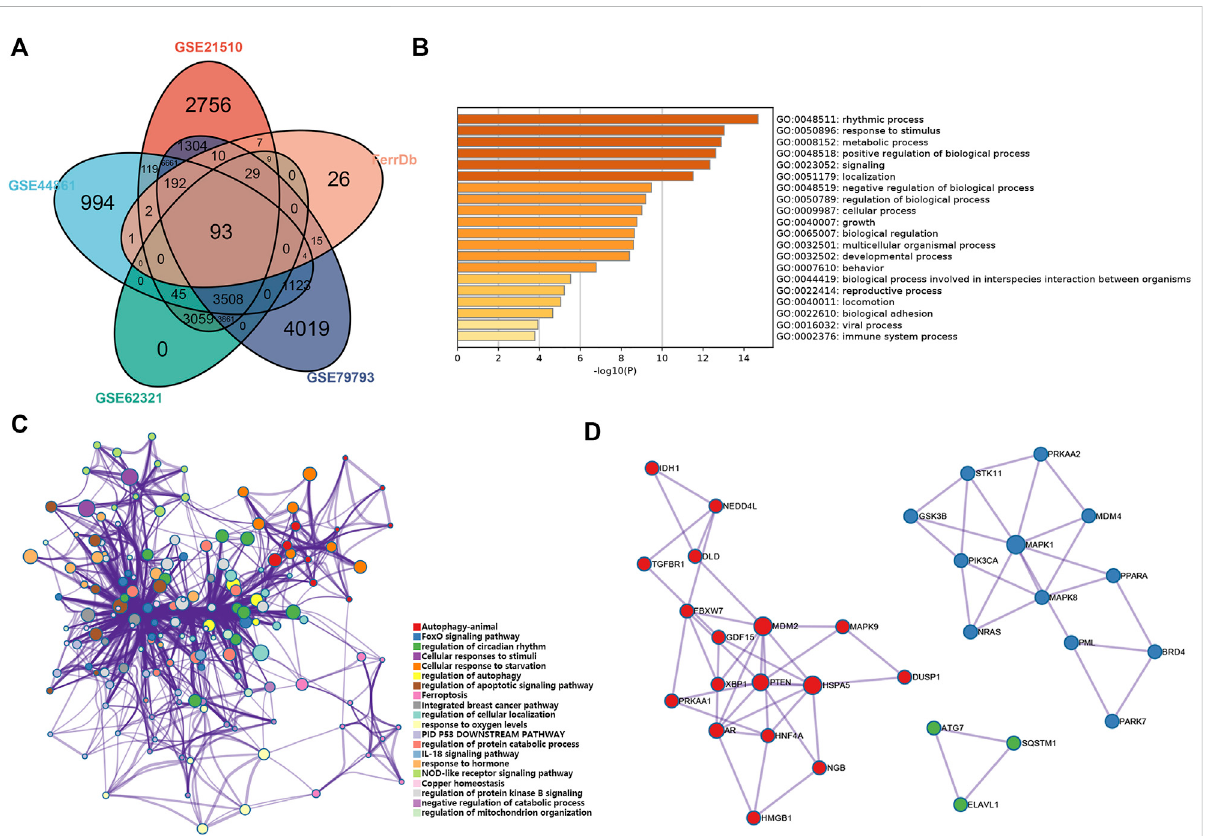
FIGURE 2 Analysis of the ferroptosis-related DEGs in CRC. (A) Venn diagram of the abnormally expressed ferroptosis-related genes that common to the four datasets (GEO: GSE 21510, GSE44861, GSE62321, and GSE79793) and FerrDb database. (B,C) Bar plot (enriched p -value) and network (enriched termsclusterID)showedthedistributionandrelationshipsofvariousfunctionsbasedontheGOandKEGGanalysisbyMetascape. (D) ThreeMCODE identi fi ed in the PPI network displayed the ferroptosis-related hub